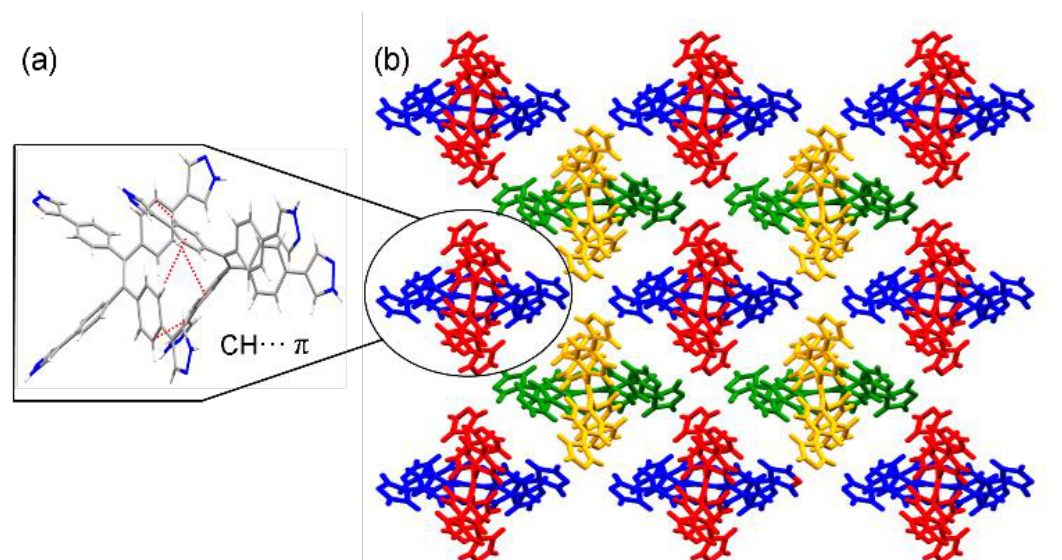
Figure 4. Crystal structure of HOF-3 . ( a ) View of the structure and the connection of adjacent building blocks. ( b ) The stacking of 2D layers.